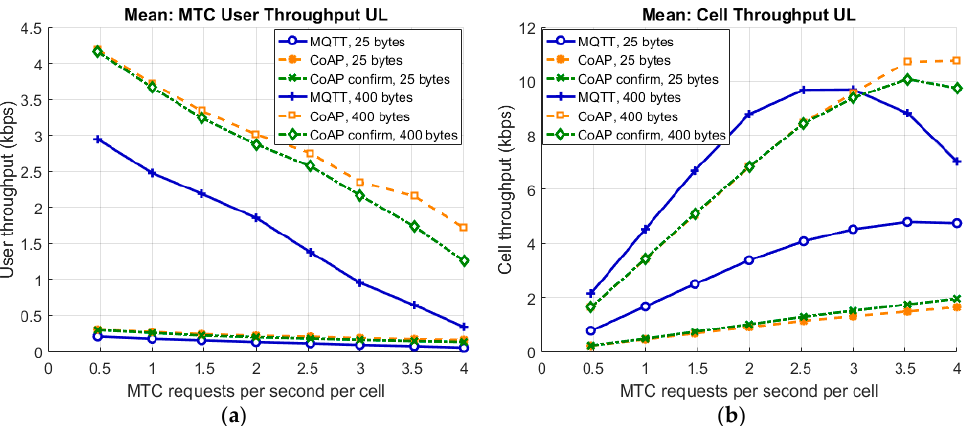
Figure 2. MTC application level throughput as a function of system load for ( a ) a single device; ( b ) on cell level.